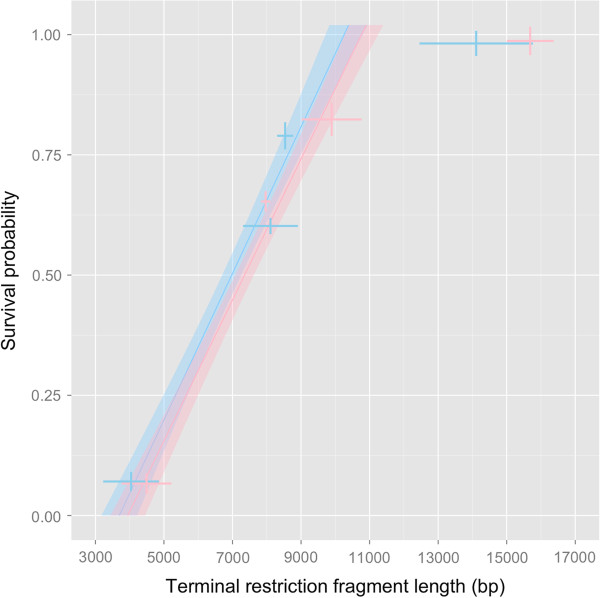
A prediction model established to forecast survival probability from hepatic telomere length in O. latipes. The survival probability is grossly proportional to the hepatic TRF length (R2 = 0.893). ‘Zero’ survival probability of male and female O. latipes is equivalent to a ‘critical’ length of ca. 3.8 kbp. Crosses are overlaid error bars (95% CI) for survival probability (vertical) and hepatic telomere length (horizontal).